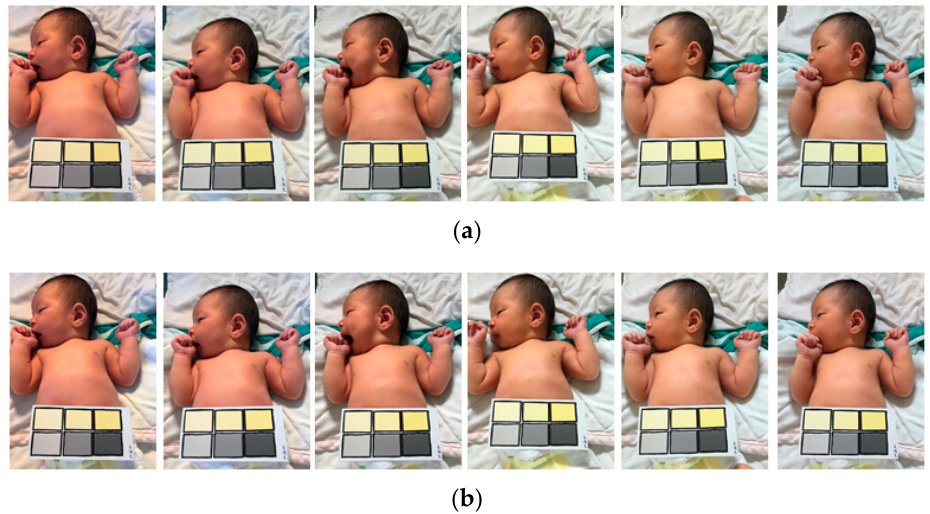
Figure 7. Low risk of bilirubin level in control group. ( a ) Original images; ( b ) adjusted images with the proposed method.